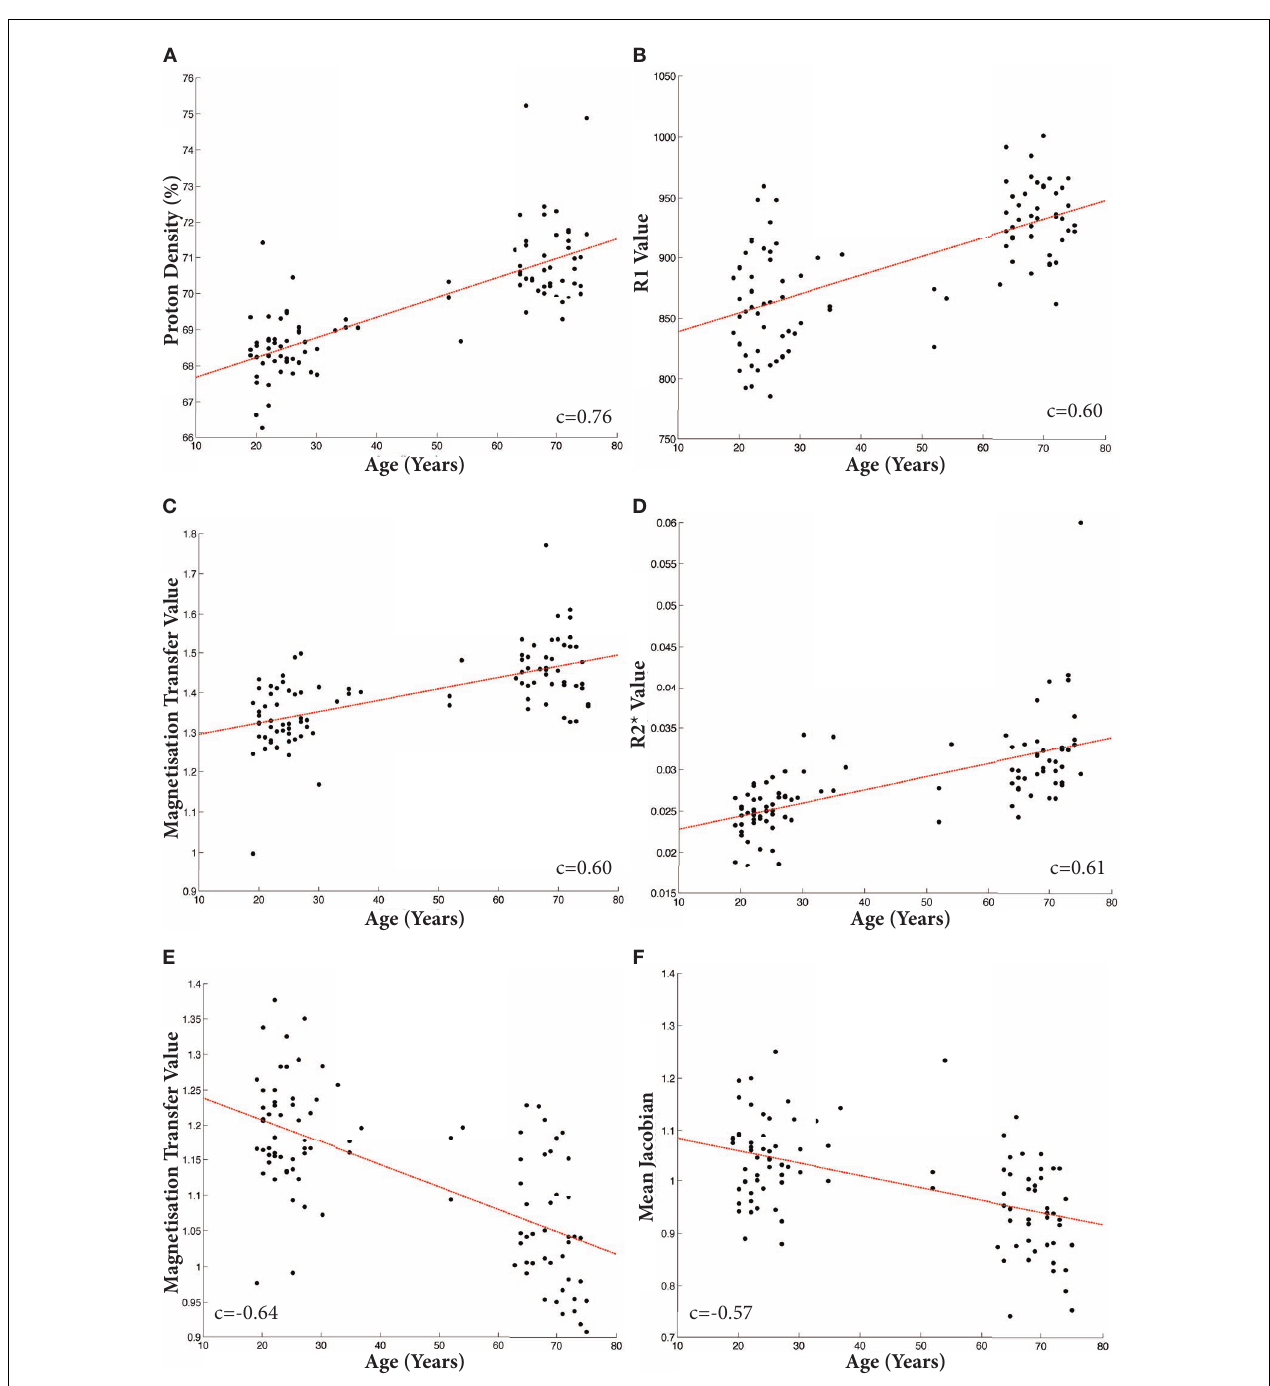
FIGURE 5 | Scatter plots of mean individual values extracted from binarizedT-maps at p < 0.001 uncorrected . Linear fit shown in red. Increases: (A) Proton Density; (B) R1; (C) MagnetizationTransfer; (D) R2 * . Decreases: (E) . MagnetizationTransfer; (F) .TBM. All Pearson’s correlation coefficients significant at p < 1 × 10 − 8